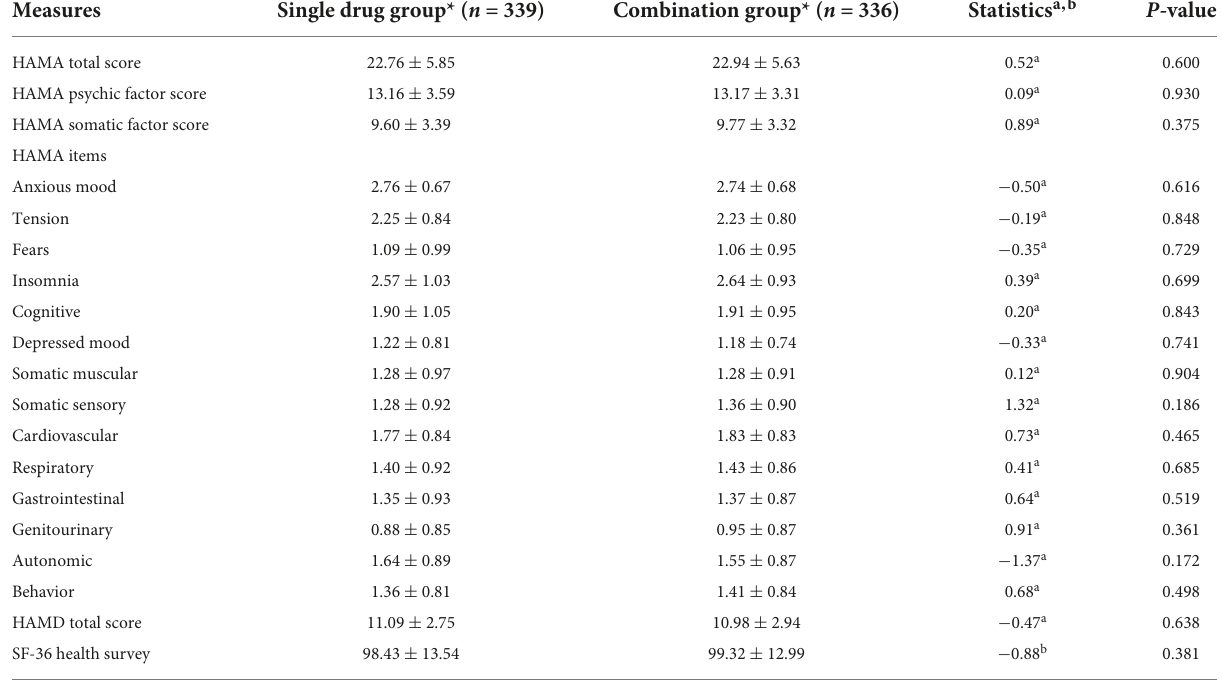
TABLE 2 Comparison of baseline psychological and somatic factors between patients with generalized anxiety disorder treated with Jiuwei Zhenxin granules alone (single drug group) or in combination with alprazolam (combination group). Measures Single drug group* ( n = 339) Combination group* ( n = 336) Statistics a , b P -value